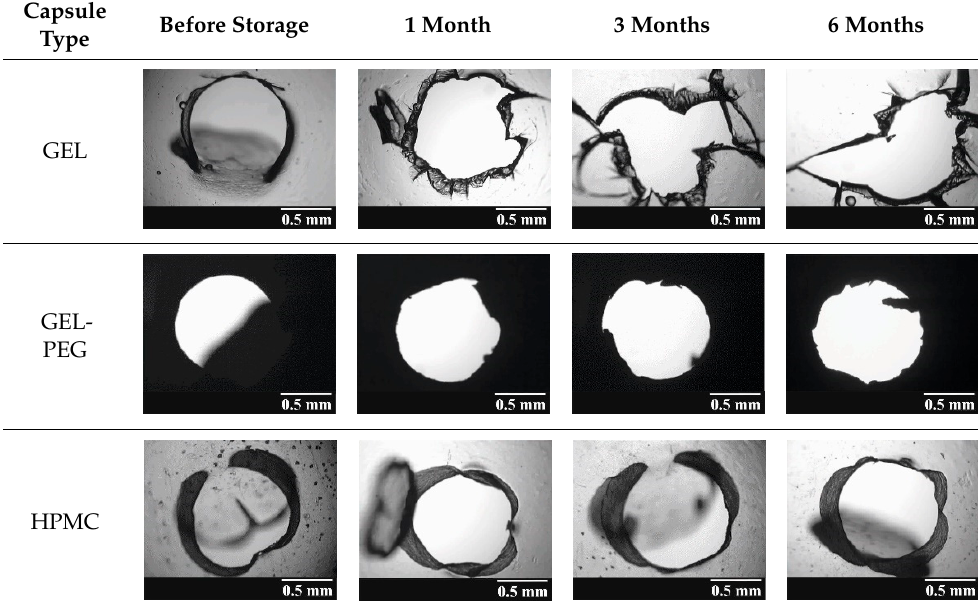
Table 3. RSC of capsule walls and areas of holes formed during